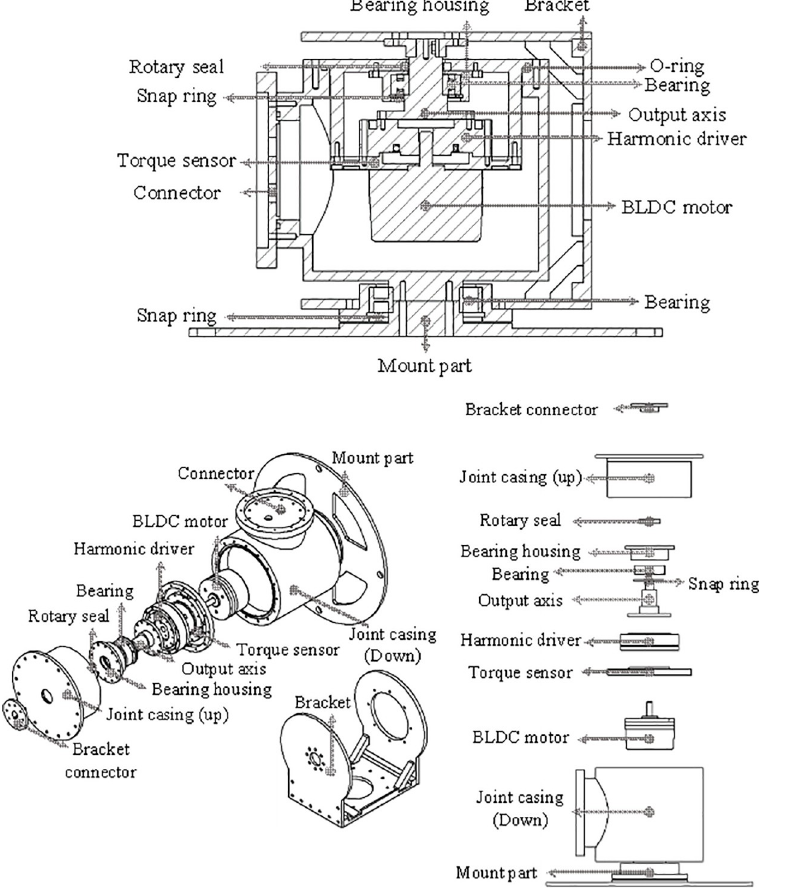
Fig 10. Detailed description of a manipulator